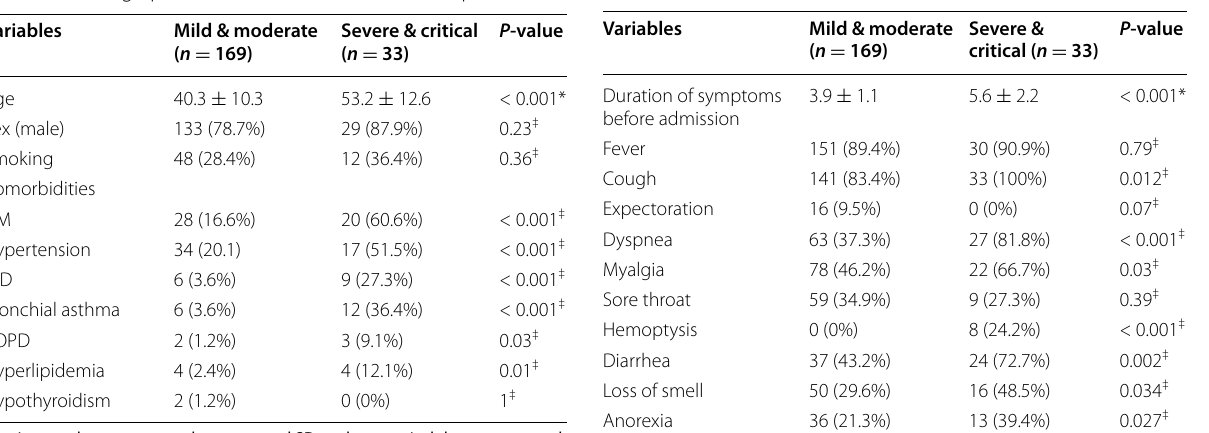
Table 2 Clinical characteristics of the studied COVID-19 patients